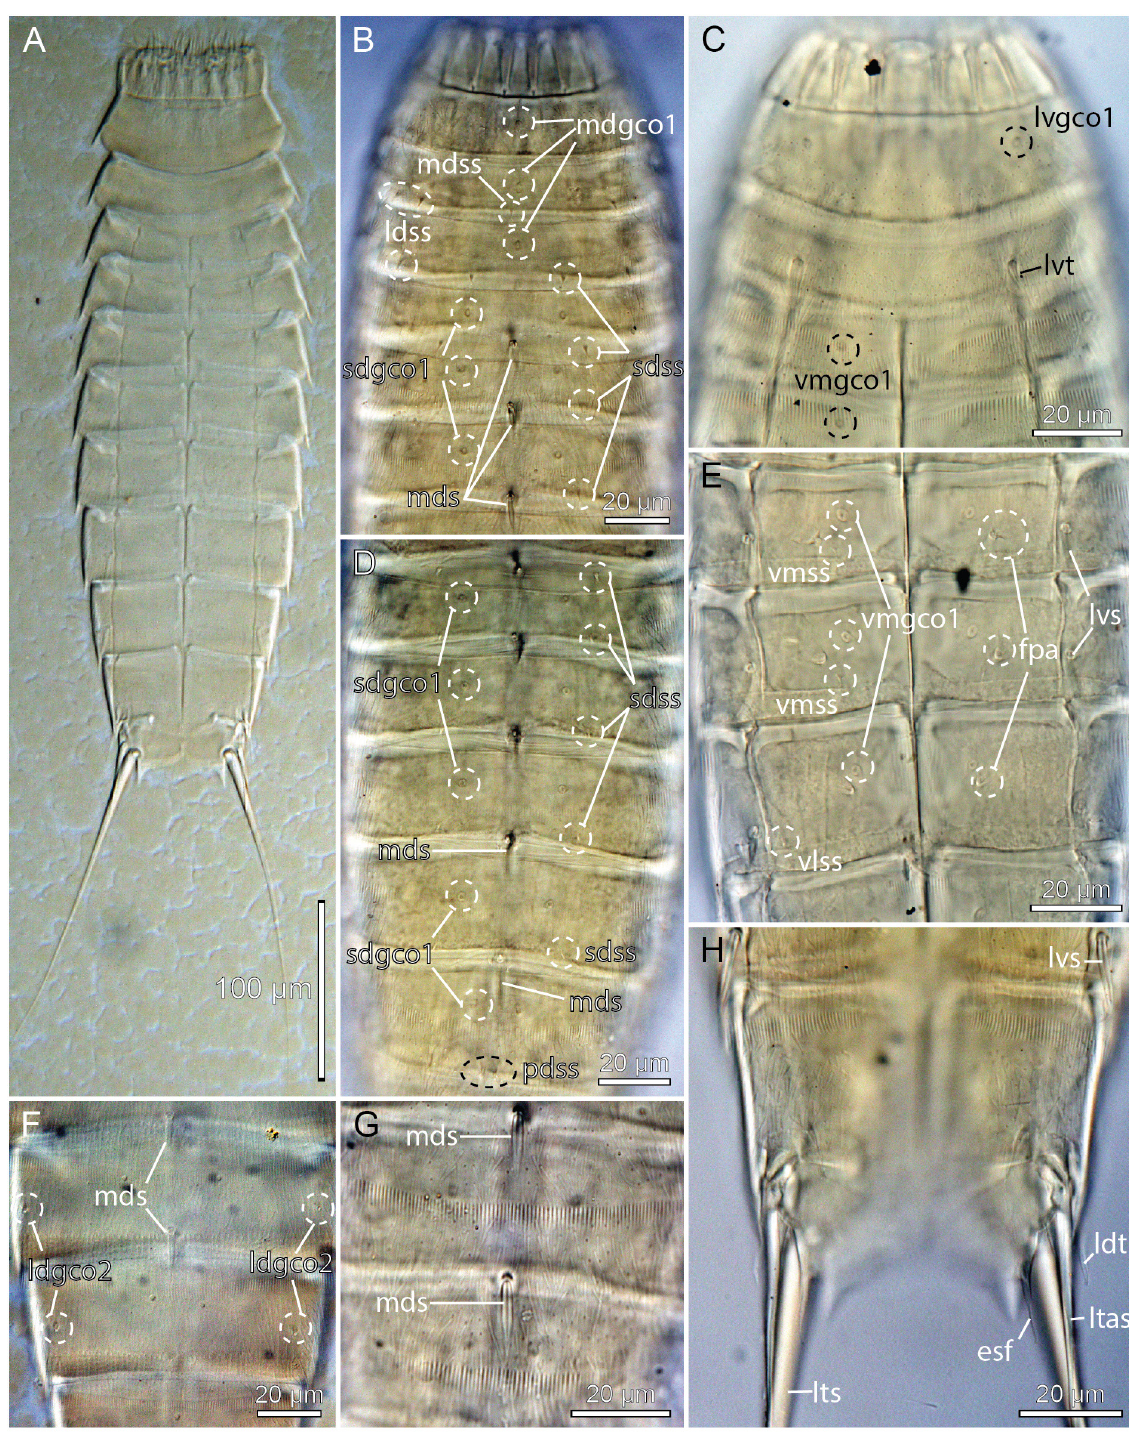
Fig. 5. Light micrographs showing overviews and details of of Echinoderes gerardi Higgins, 1978. A, F . Holotype, ♀ (USNM-54841). B–E, G–H . ♀, non-type from Turkey (NHMD-616810). A . Ventral overview. B . Segments 1 to 6, dorsal view. C . Segments 1 to 4, ventral view. D . Segments 5 to 9, dorsal view. E . Segments 6 to 8, ventral view, showing female sexual dimorphism. F . Segments 8 to 9, dorsal view. G . Detail of segments 7 to 8 showing middorsal spines. H . Segments 10 to 11, ventral view, showing female sexual